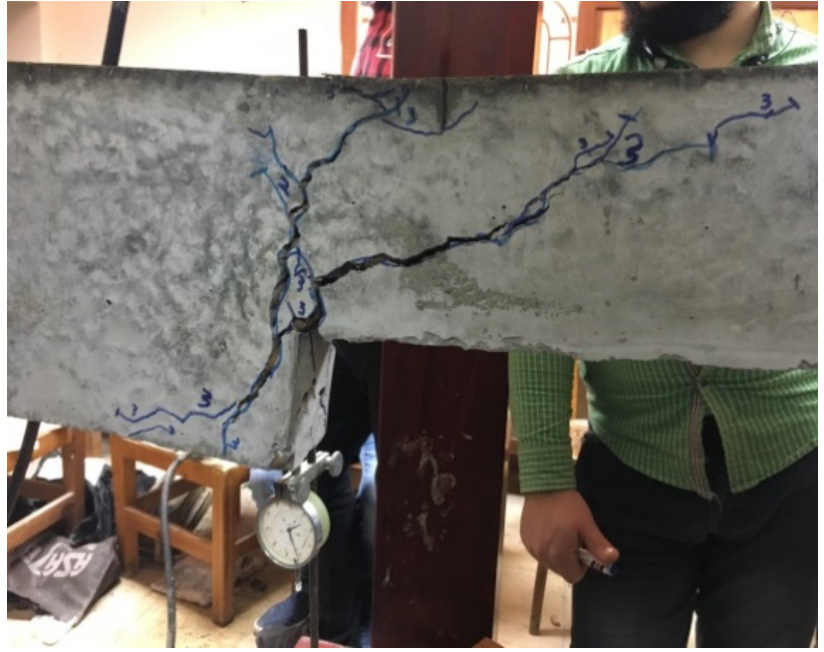
Figure 11. The crack pattern of beam B2.